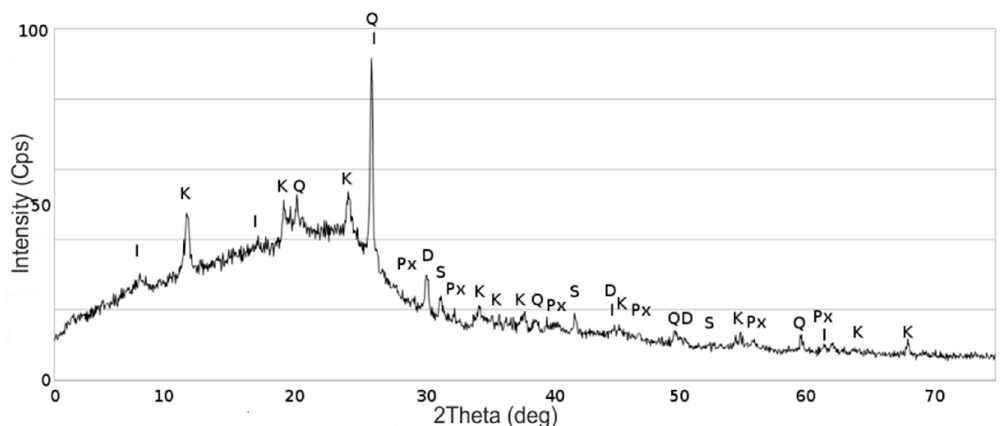
ff raction pattern for bituminous coal sample from the Janina deposit. Figure 2. X-ray diffraction pattern for bituminous coal sample from the Janina deposit. Q—quartz, Figure 2. X-ray di